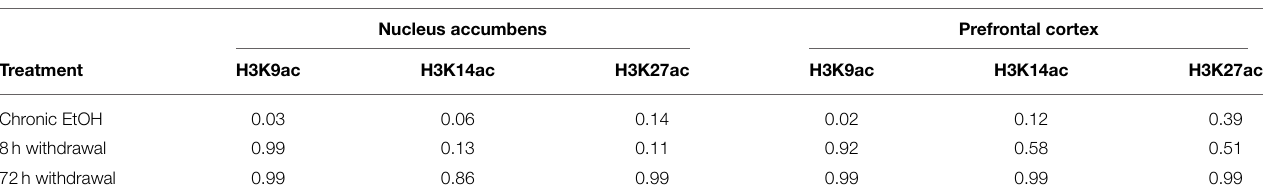
TABLE 3 | Summary of Bonferroni post-hoc tests for Experiment